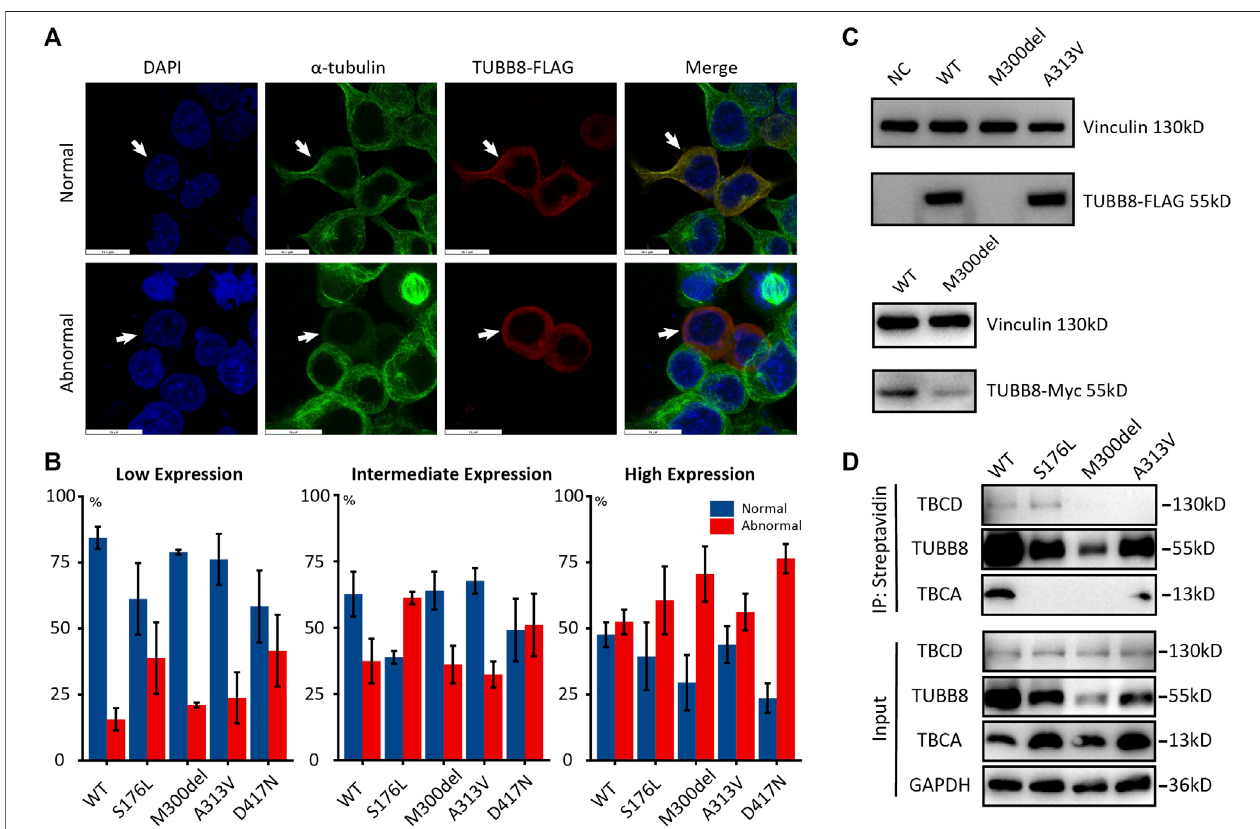
FIGURE 4 | In vitro disruption of microtubule network by WT and mutant TUBB8. (A) Microtubule phenotypes resulting from expression of wild-type and mutated TUBB8- fl ag transfected in HEK293T. α -tubulin (green) showed the endogenous microtubule network, and M2-FLAG (red) detected the expression of the transgene. Microtubules assembled into a regular network in the normal group, while the abnormal group showed a mottled pattern. The bar in normal pattern indicates 15.3 µm, and the bar in the abnormal pattern indicates 15 µm. (B) The quantitative analysis of microtubule phenotypes in panel. Approximately 200 transfected cells were examined. I bar indicates standard error. (C) Western blot of overexpressions of wild-type and mutant TUBB8. NC was a blank load transfection negative control. WT was overexpressions of wild-type TUBB8 in HEK293T. M300del showed no visible protein band when detected with anti- fl ag antibody, while WT and A313V had comparable expression levels. When repeated with anti-Myc antibody, M300del still had a blurry band. (D) Co-IP of TUBB8 and tubulin cofactors. WT and A313V kept interactingwithbothTBCDandTBCA,andS176LlostbindingwithTBCAbutmaintainedinteractionwithTBCD.M300delhadnointeraction